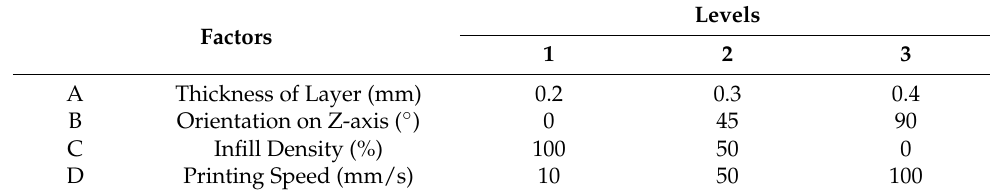
Figure 3. Graph of tensile strength, Young’s modulus and flexural strength of oil palm fiber reinforced thermoplastic composites. Table 1. Factors and their levels.